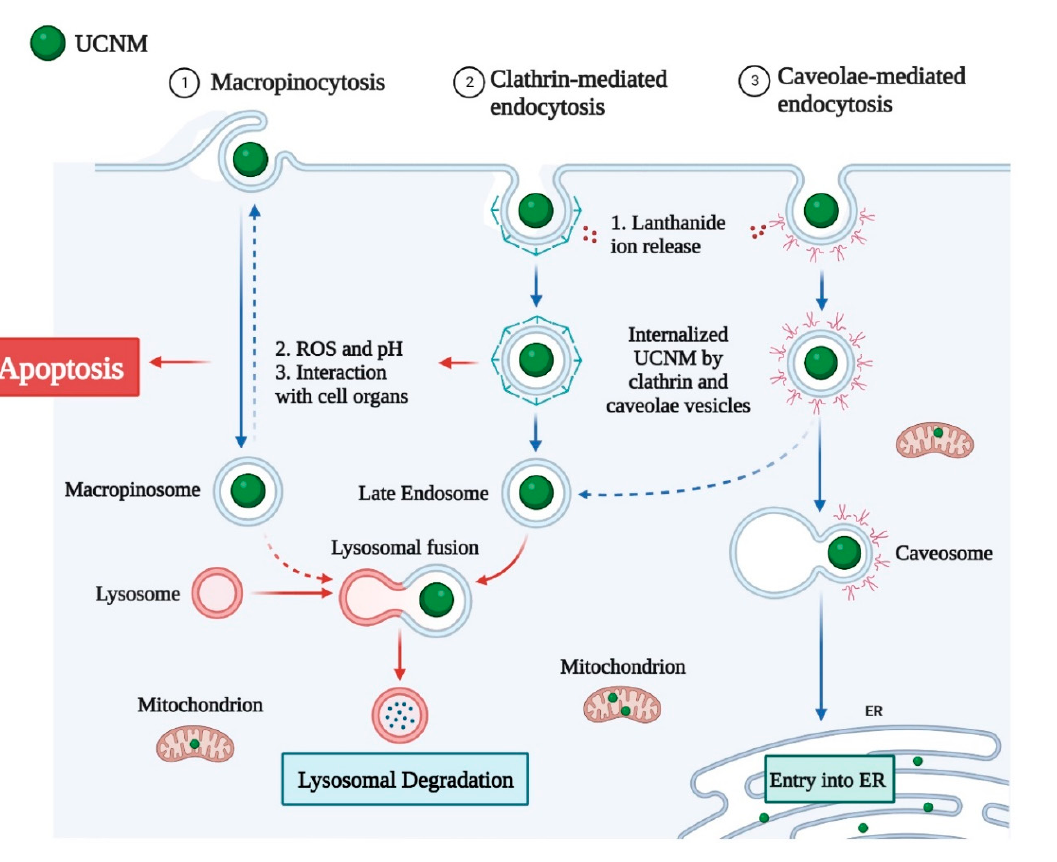
Figure 3. Cellular uptake and intracellular mechanism of upconversion nanomaterials.